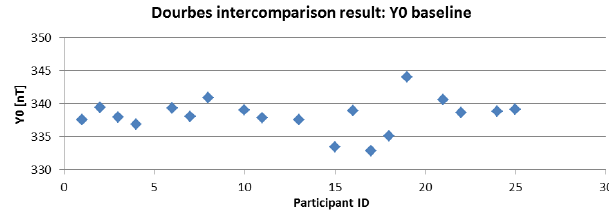
Figure 6. Result of the intercomparison session organized during the XVIIth IAGA Workshop on Geomagnetic Observatory instru- ments, data Acquisition and Processing. Each value corresponds to the mean result of an observer/instrument series performed on pillar D05. Eastern component Y 0 is shown.